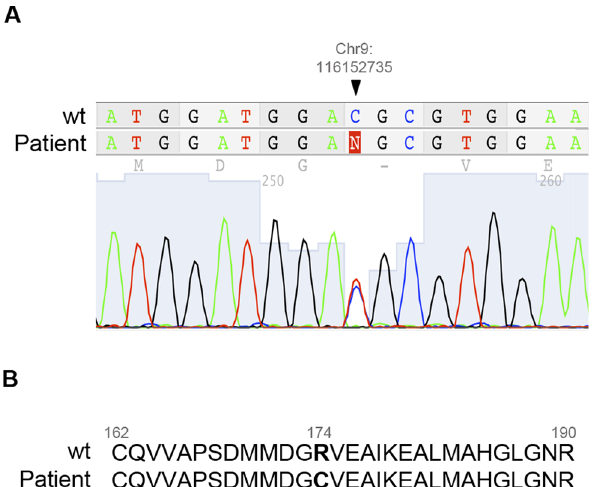
116,152,735 position in exon 7. (B) Protein sequences from wild-type and RARS patient. Amino-acid change in the protein sequence of ALAD in a RARS patient. Arginine (R174) is replaced by cysteine y the mutant protein. (RARS: refractory anemia with ring